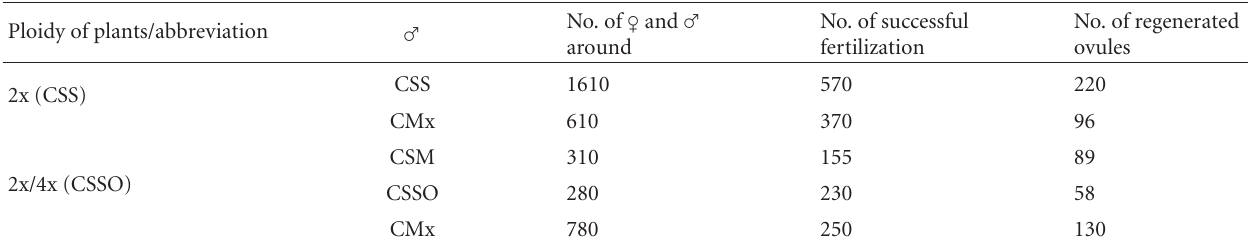
Table 4: Summary of in vitro pollination of C. sativus (2x; 2x/4x) × Cucumis spp. Ploidy of